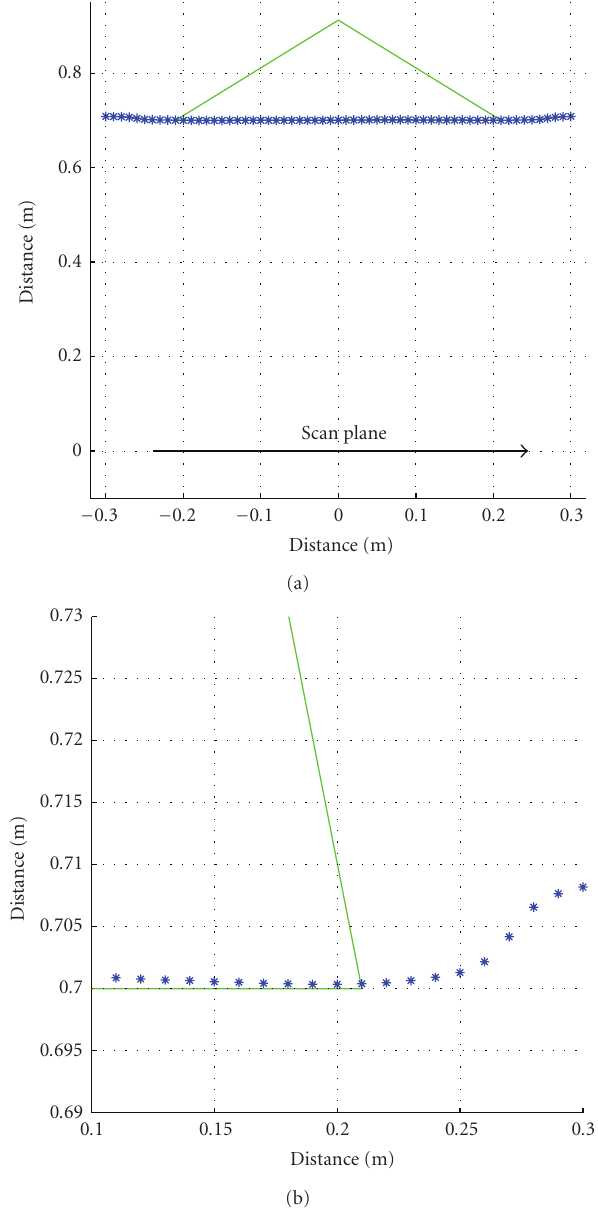
Figure 3: Wave front extraction with planar scan surface of a triangle object (a) and zoom of its right corner of the hypotenuse (b).